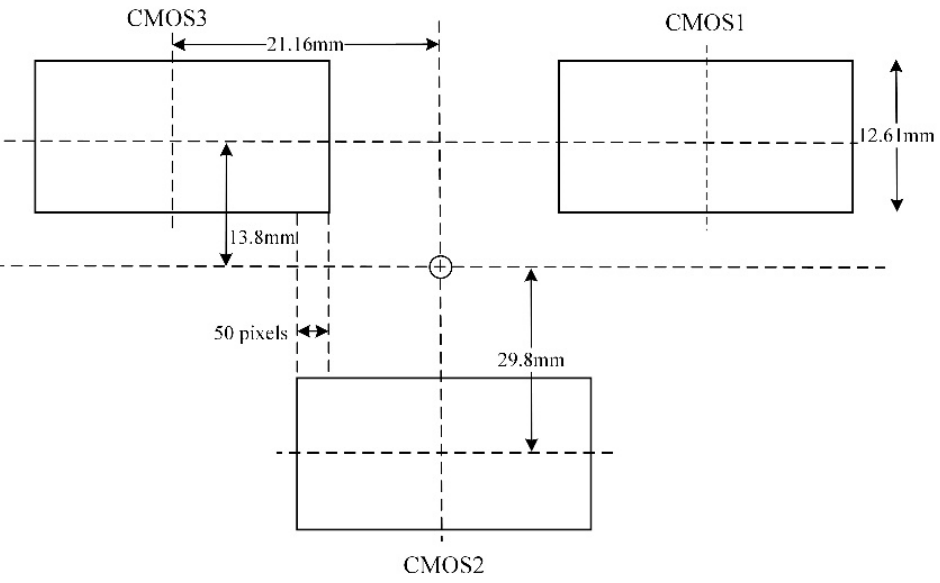
Figure 1. Focal plane arrangement for the hyperspectral camera.